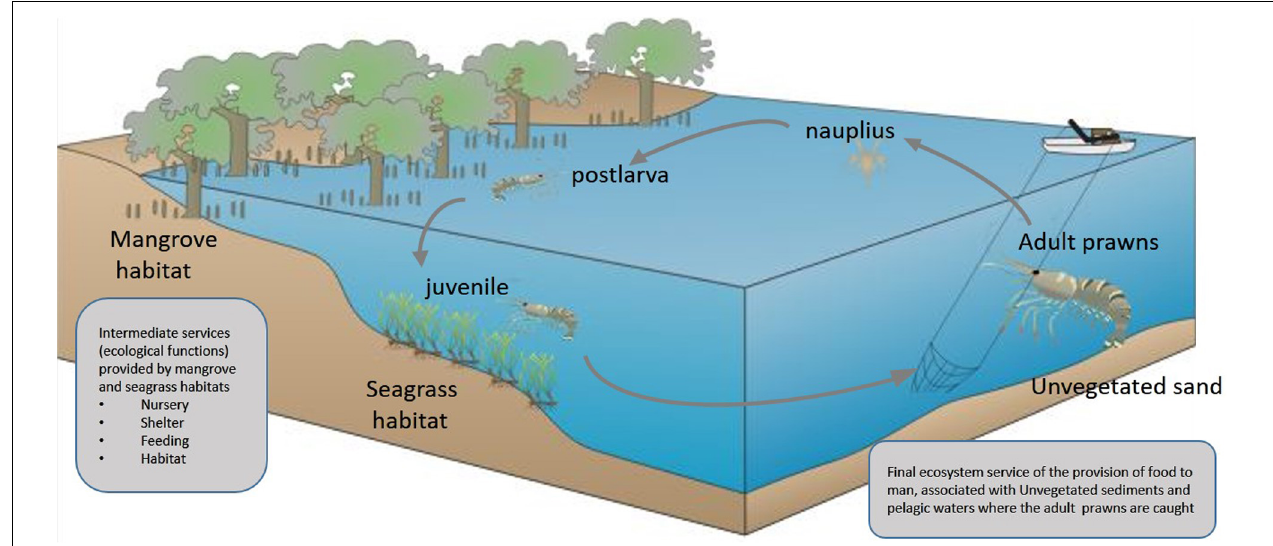
FIGURE 2 | Diagram showing connectivity between VCE for the Penaeid prawn lifecycle indicting that valuations for harvest areas may overlook critical importance within the